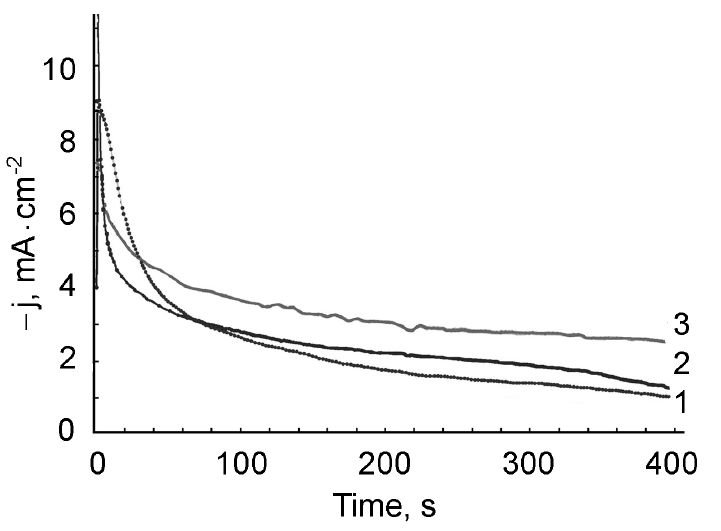
Figure 10. Current density versus electropolymerization time and electrolyte composition: electrolyte